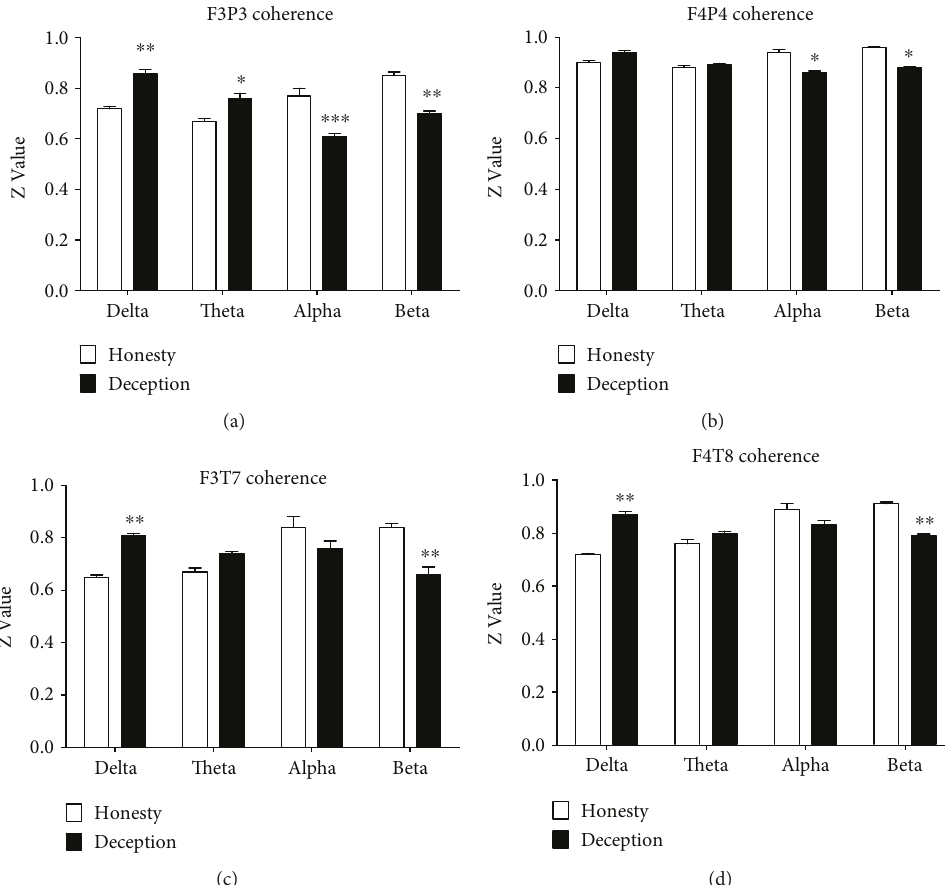
Figure 3: The mean z values of the honesty and deception groups for the four frequency bands. (a) The F3P3 electrode pair. (b) The F4P4 electrode pair. (c) The F3T7 electrode pair. (d) The F4T8 electrode pair. ∗ p < 0 05 , ∗∗ p < 0 01 , and ∗∗∗ p < 0 001